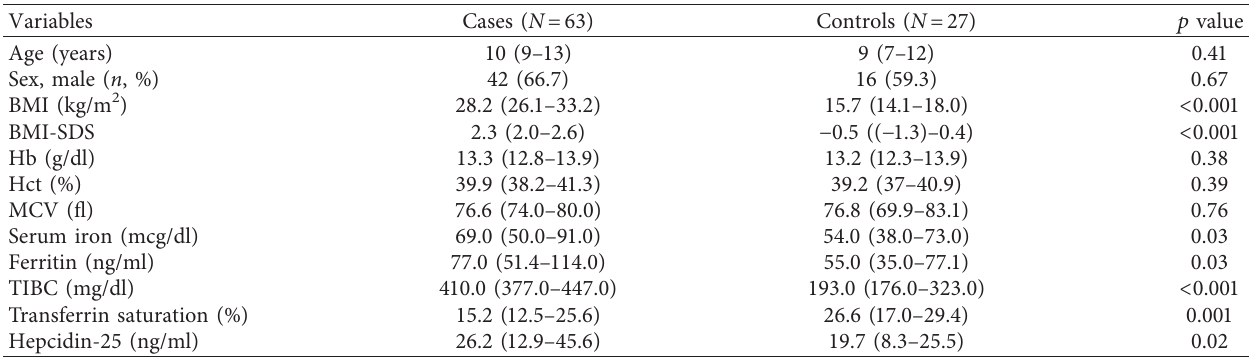
Table 1: Anthropometrical and biochemical features of the obese group versus controls.